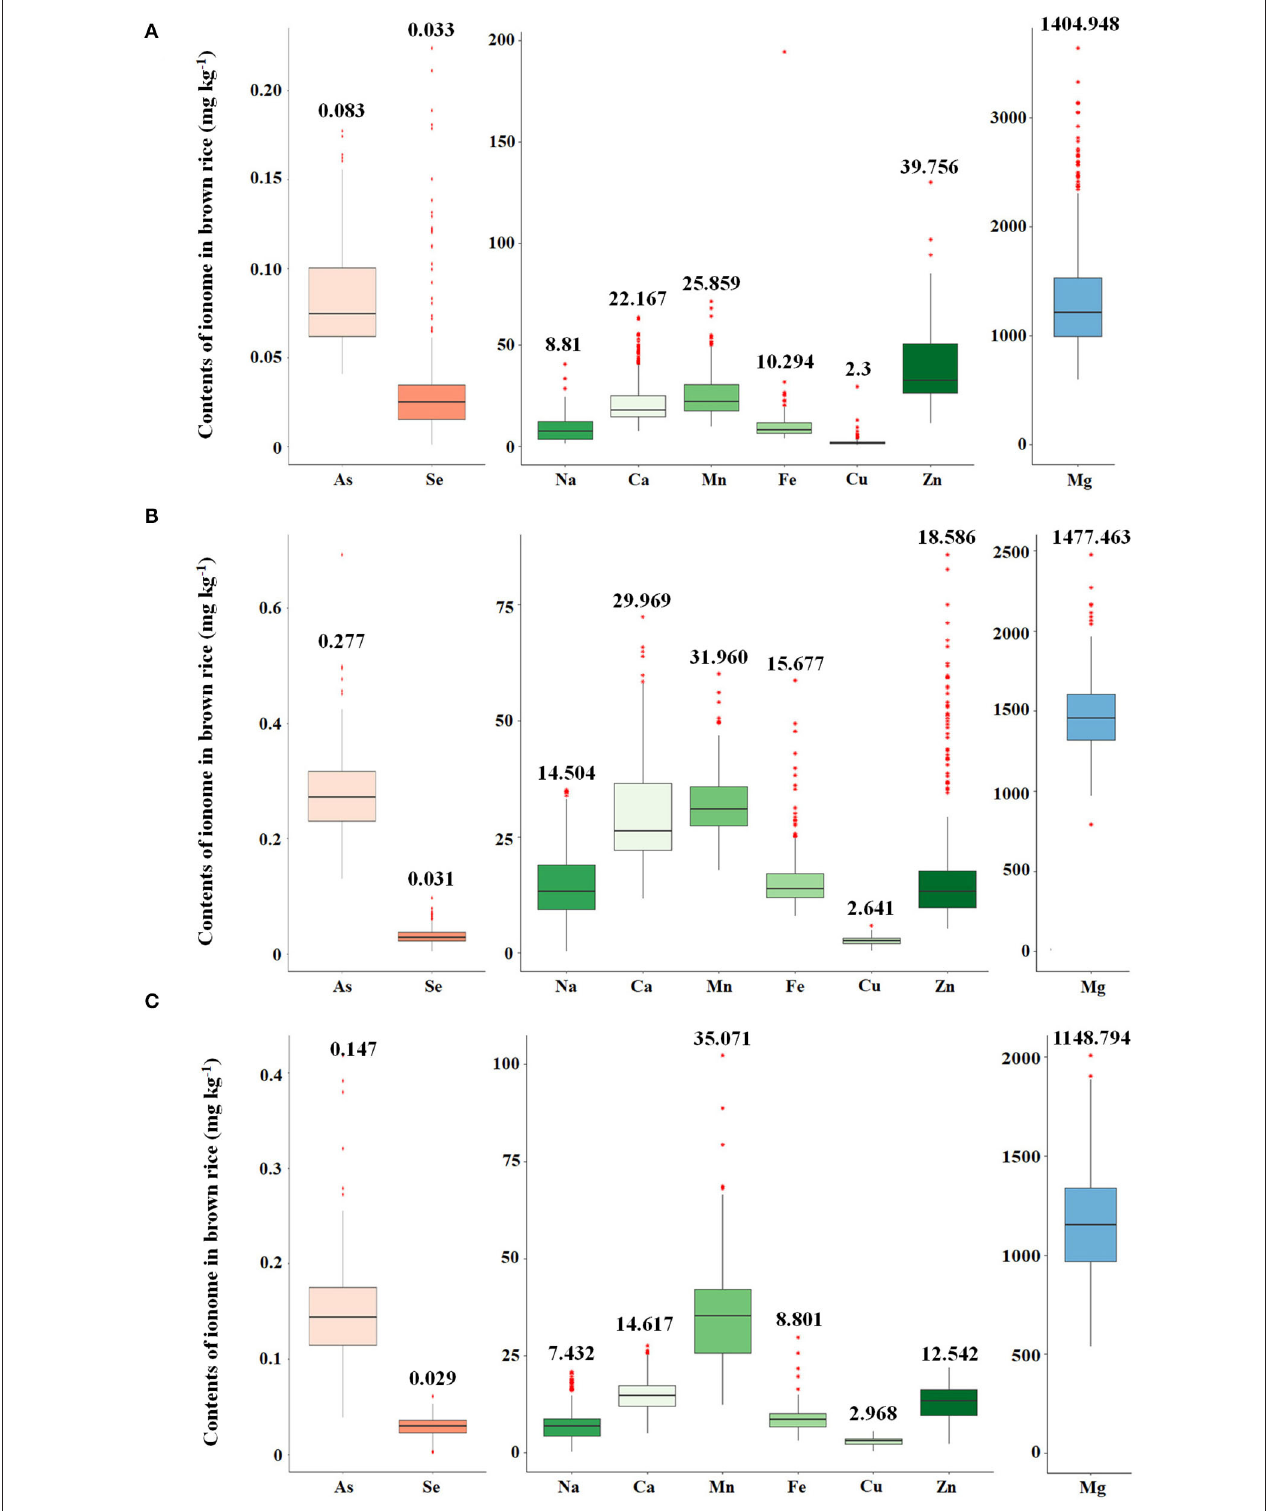
FIGURE 1 | Variation of arsenic and functional ion content for the 273 rice accessions. (A) Ion contents in 273 rice grains in non-contaminated soil. (B) Ion contents in 273 rice grains under the flooded condition in contaminated soil. (C) Ion contents of 273 rice grains under the intermittently flooded condition in contaminated soil.